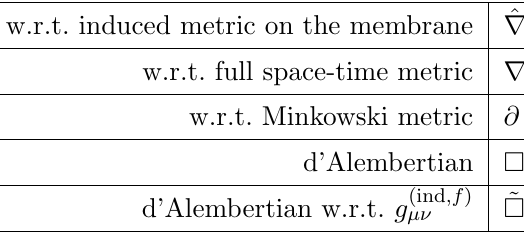
Table 5 . Di(cid:11)erential